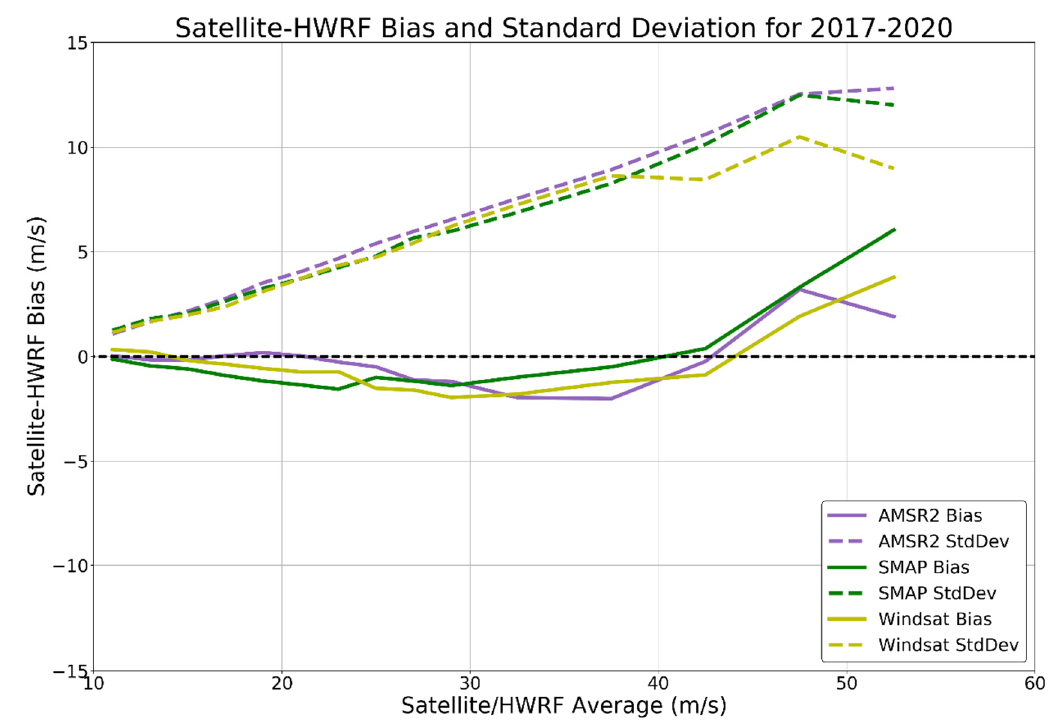
Figure 13. Biases (solid lines) and standard deviations (dashed lines) between each of the three sensors and HWRF binned vs. average satellite/HWRF winds. Bins with a width of 2 m/s were used between 10–30 m/s. Bins with a width of 5 m/s were used for average winds >30 m/s. This was done to ensure the bins were sufficiently populated. If there were less than 50 matchups in a given bin, it was not included in this figure. The black dashed line is the zero-bias line.